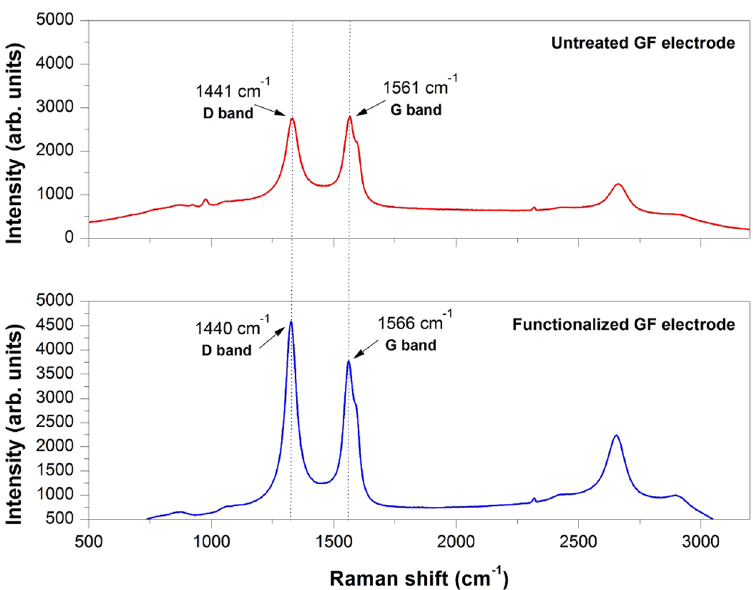
Figure 3. Typical Raman spectra of graphene film and functionalized graphene film electrode in this